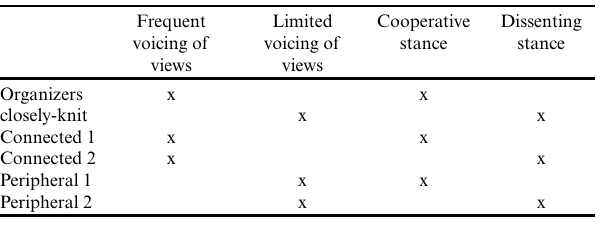
Table 3 . Contours of involvement of stakeholders